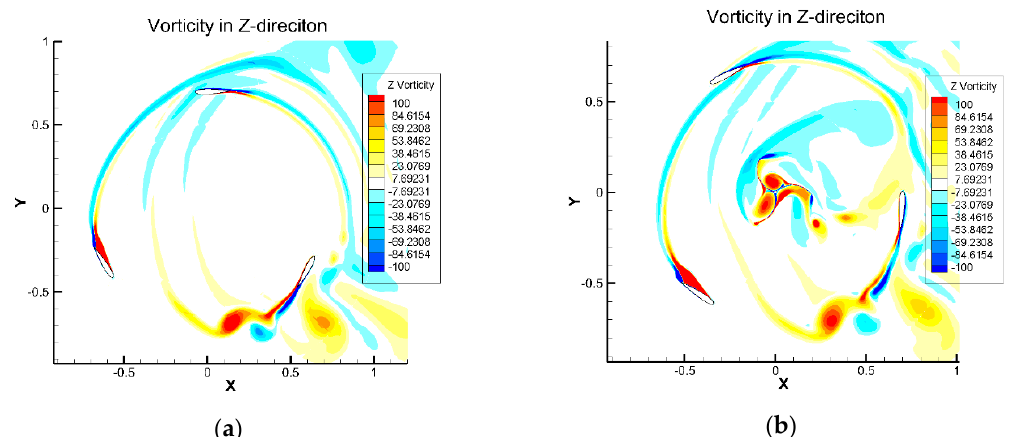
Figure 9. Instantaneous vorticity fields around the ( a ) H-type and ( b ) hybrid VAWTs. Table 2. Summary of parameters in CFD simulation.